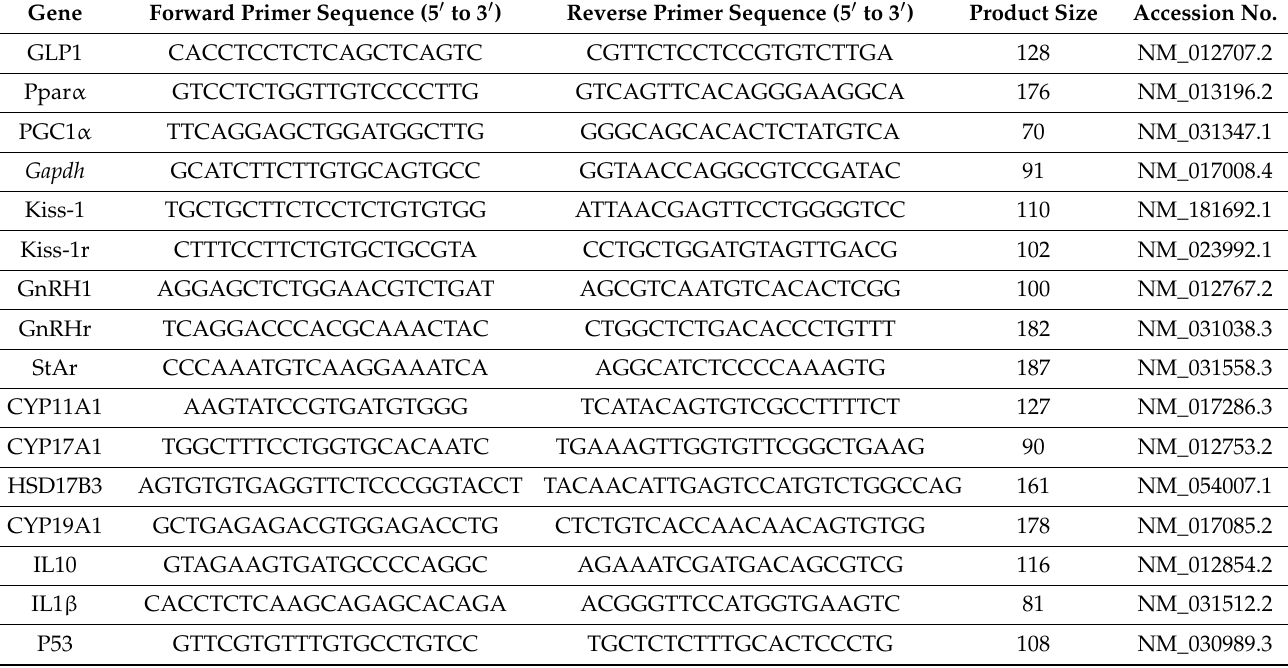
Table 1. Forward and reverse primers sequence of targeted